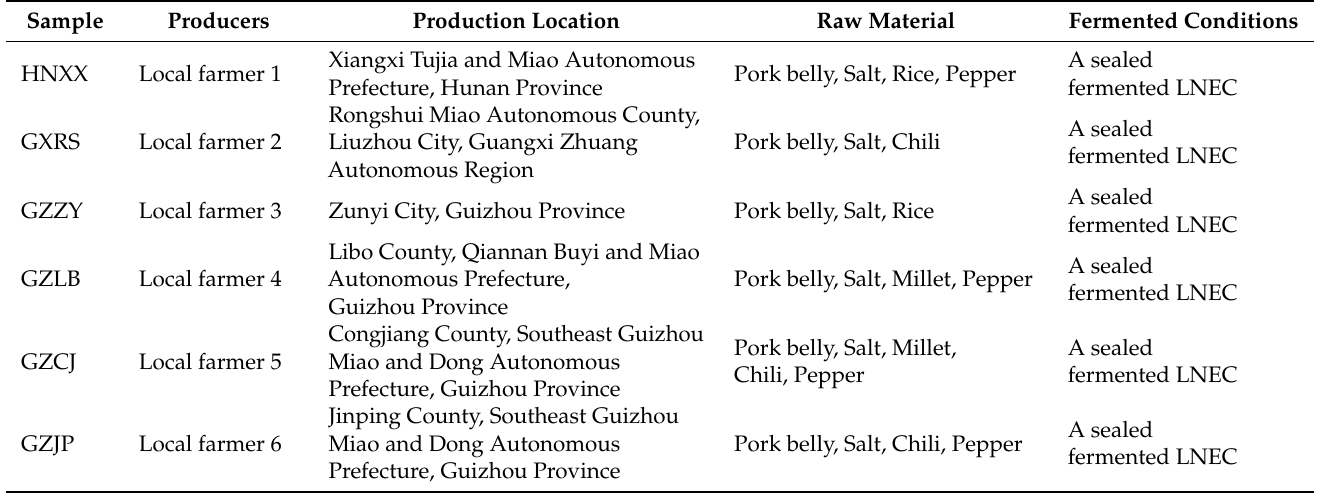
Table 1. Information about the Suan Rou samples tested in this study.